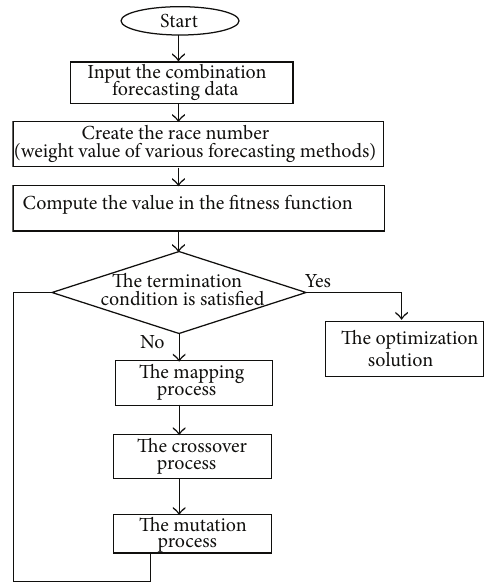
Figure 6: Flowchart of the proposed hybrid GA-based